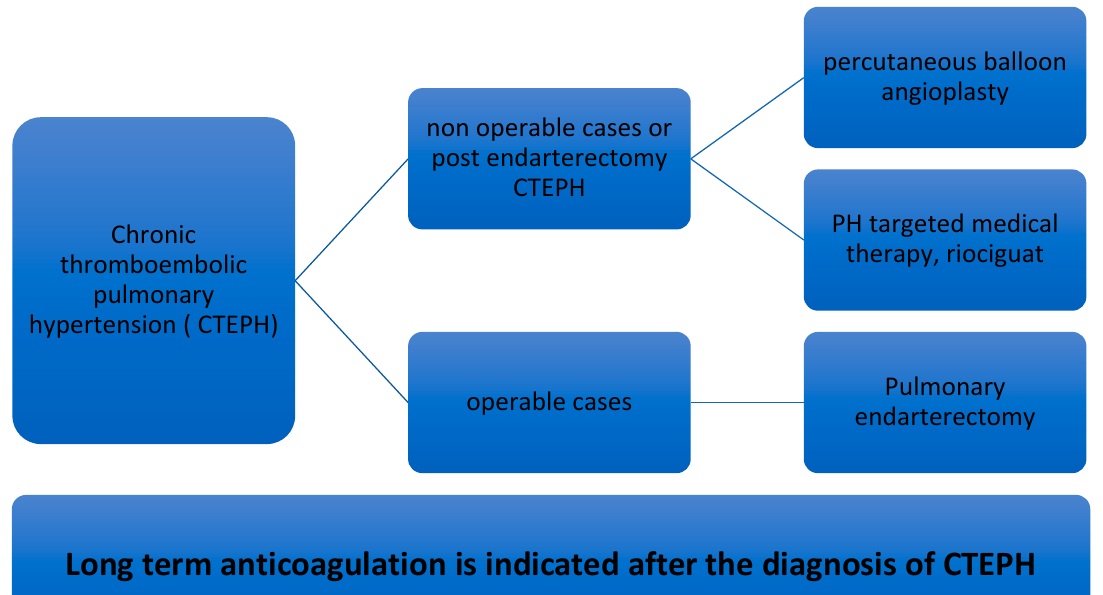
Figure 2. Definitive treatment options for chronic thromboembolic pulmonary hypertension.